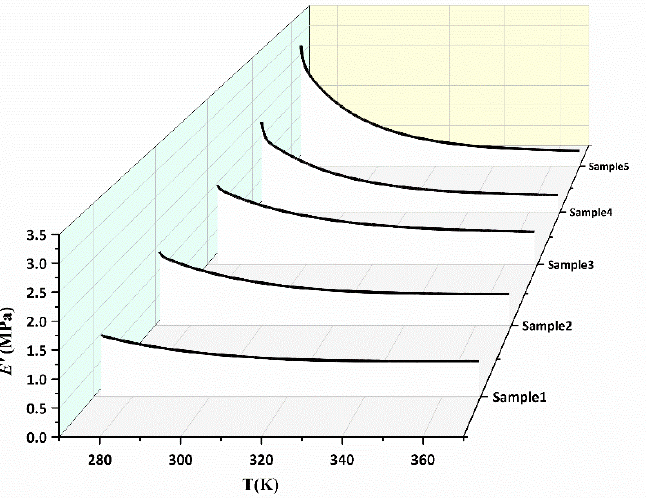
Figure 7. Elastic modulus of pseudo-semi IPNs as a function of temperature.